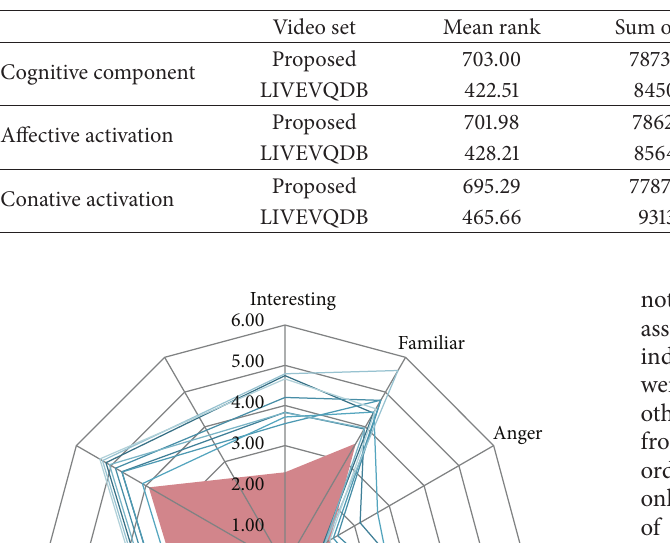
Table 6: Mental components relative to the two video sets.